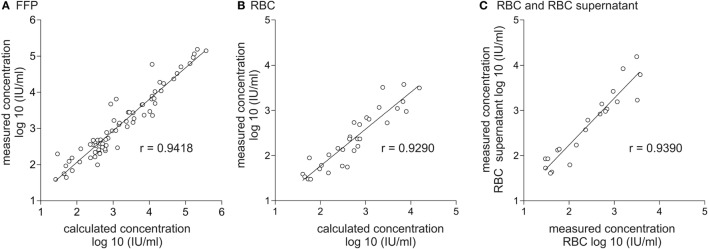
Correlation of calculated and effectively quantified viral load in fresh frozen plasma (FFP) and red blood cell concentrate (RBC) and correlation of viral load in RBC and RBC supernatant. Displayed is the correlation between the effectively quantified hepatitis E virus (HEV) titer and the expected viral load in FFP (A) and RBC (B). Calculation of the expected viral load in FFP is based on quantification results of HEV viral load in plasma of donors assuming a mean plasma content of 0.8 mL/mL plasma in the corresponding plasma product. Calculation of the expected viral load in RBC is based on quantification results of HEV viral load in plasma of donors assuming a residual plasma content of 10 mL/RBC. (C) Correlation of the effectively quantified HEV titer in RBC and RBC supernatant. The linear range of quantification was from 25 to 10E+07 IU/mL. Therefore, all values <25 IU/mL were excluded.